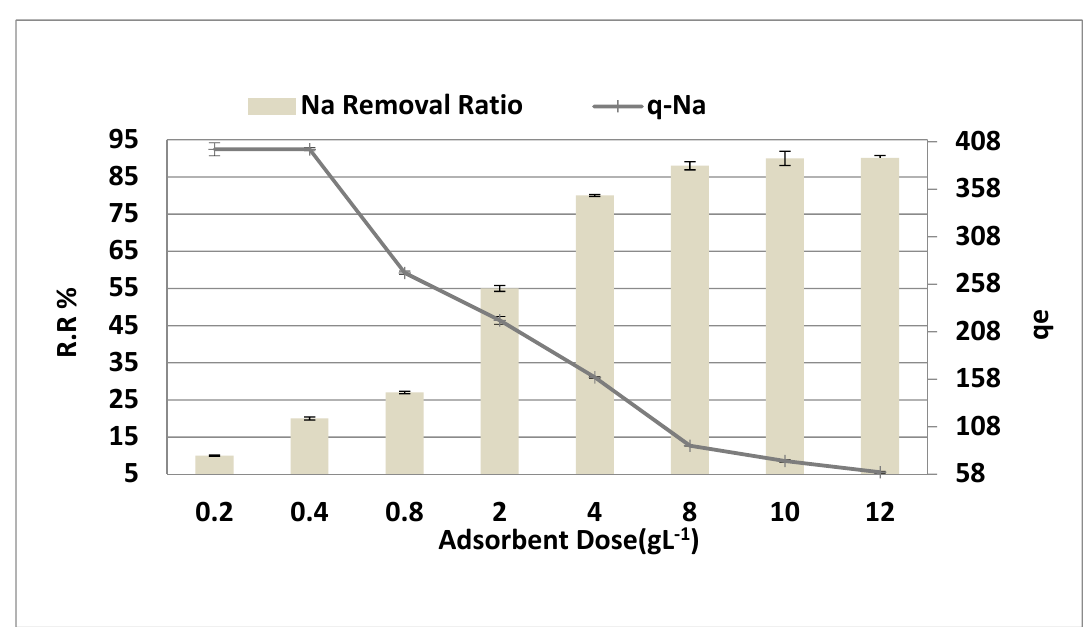
Figure 6. Adsorbent dose effect on the adsorption removal and capacity of NaCl, time = 150 min, pH = 4, and agitation speed = 300 rpm.